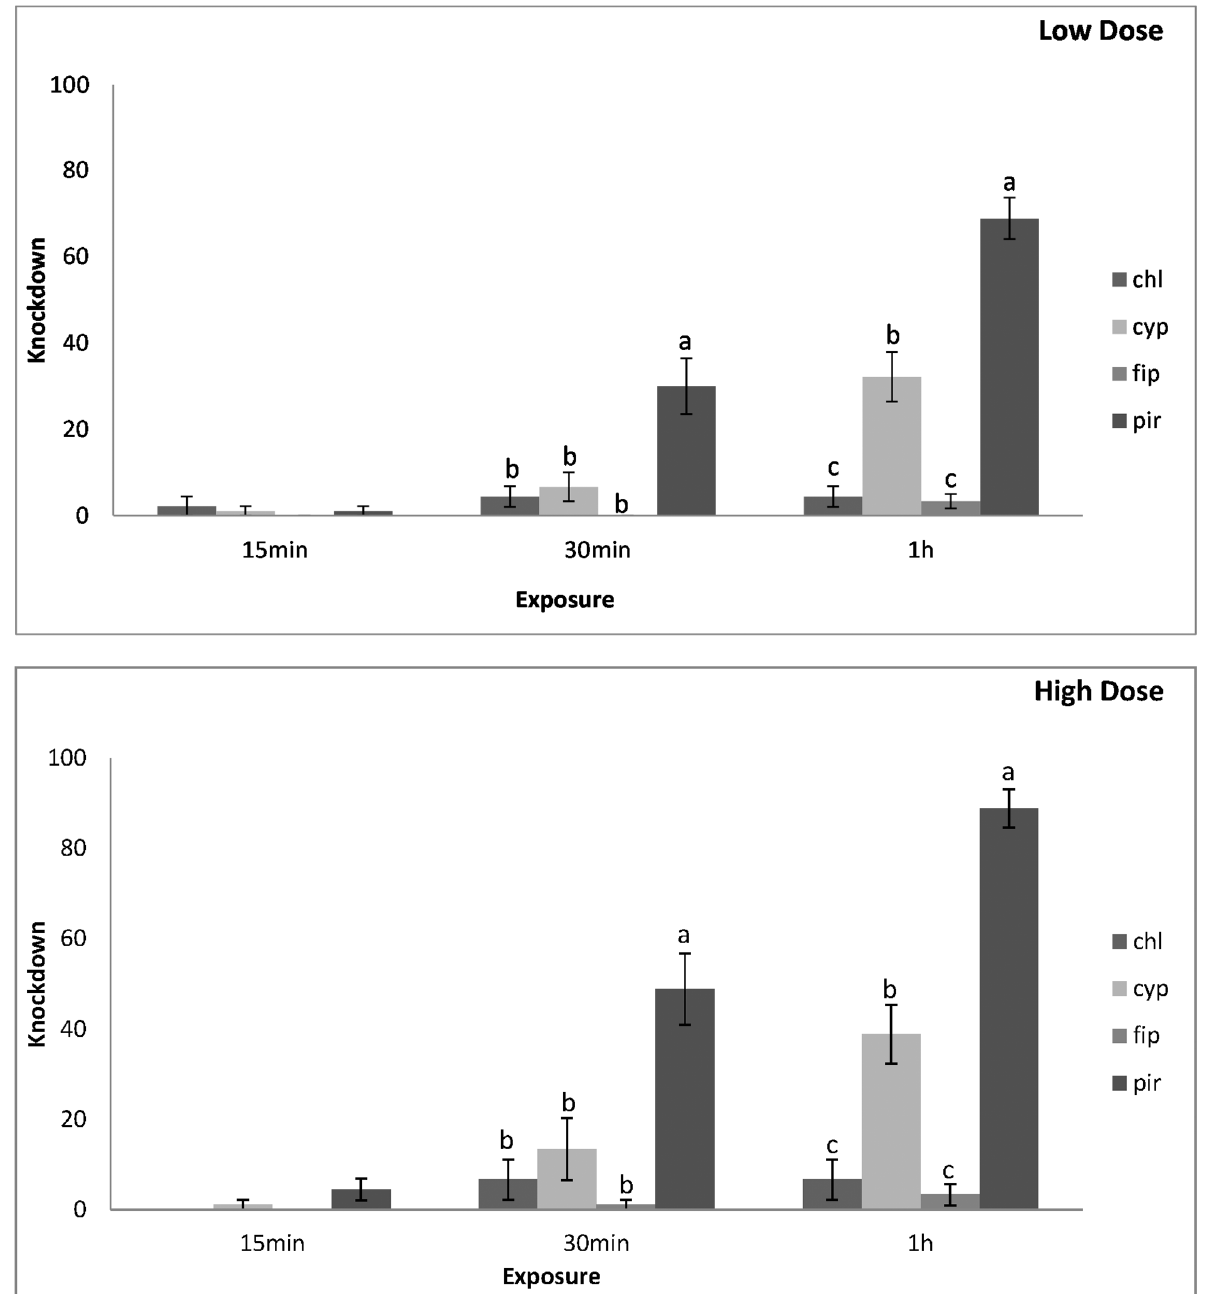
Fig 3. Mean Knockdown of O . surinamensis adults on concrete surfaces at low and high dose. Mean Knockdown (% ± SE) of O . surinamensis adults on concrete treated with chlorfenapyr (chl), alpha-cypermethrin (cyp), fipronil (fip) and pirimiphos-methyl (pir), at the low and the high dose rate of each insecticide after 15 min, 30 min and 1 h exposure